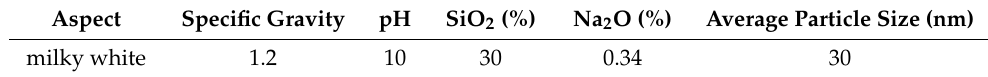
Table 2. Properties of the CNS (in liquid form).